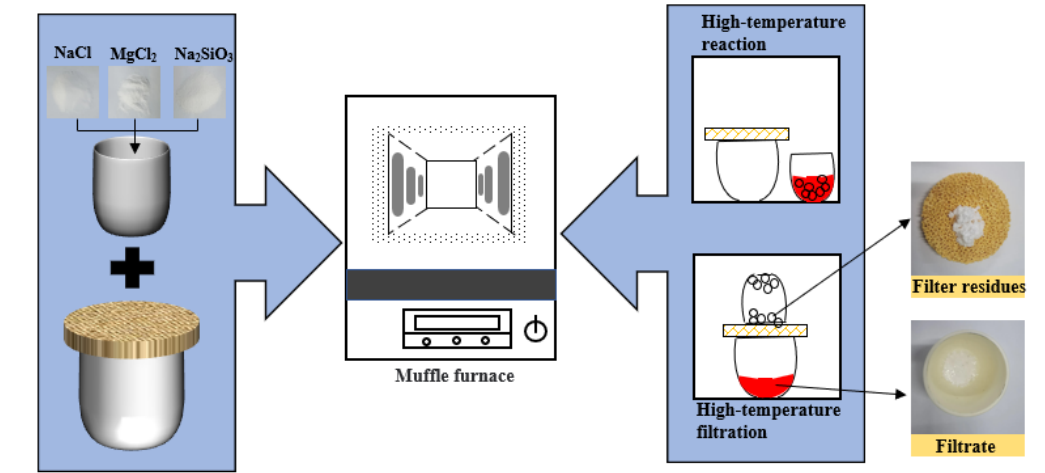
Figure 2. Schematic diagram of experiment.